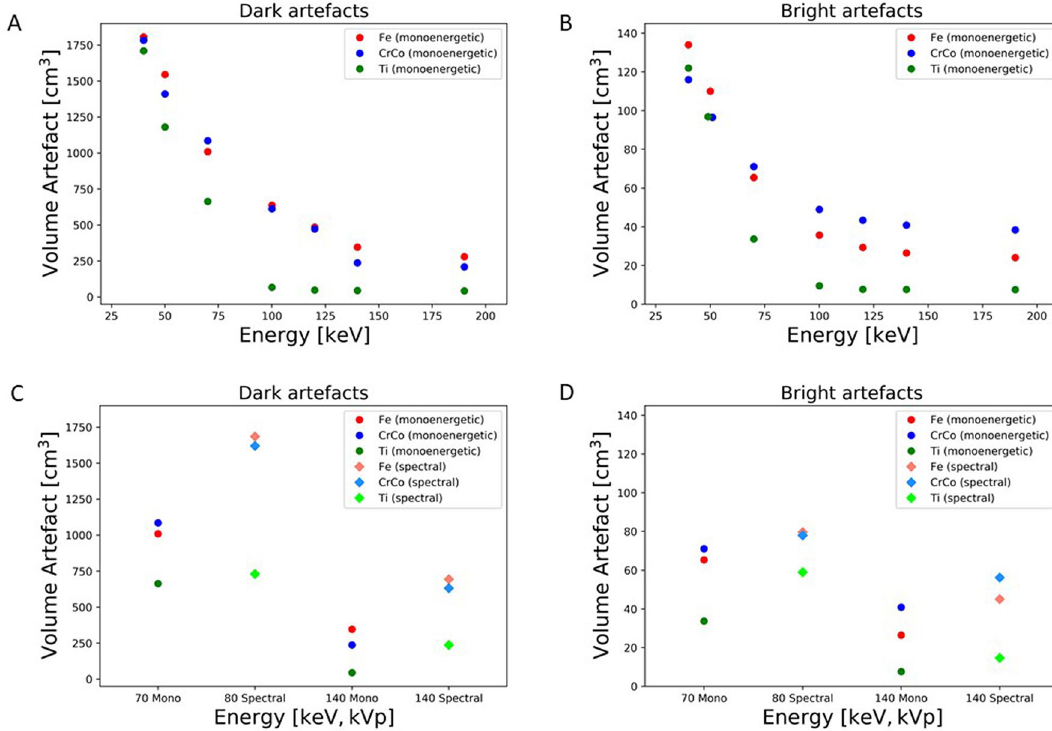
Figure 4. The graph illustrates the reduction of volume artefact with increasing energies keV for dark artefact ( A ) and bright artefact ( B ). The other two graph show the impact of volume artefact reduction between monoenergetic and spectral energies for dark artefact ( C ) and for bright artefact ( D